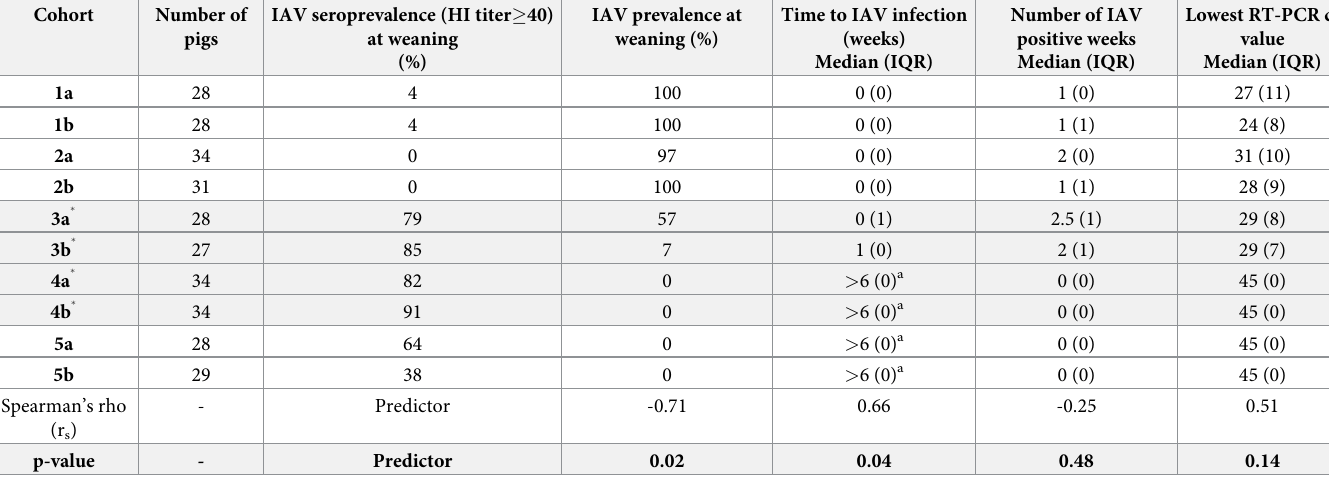
HI, Hemagglutination inhibition assay; IQR, Interquartile range; RT-PCR, Real-time reverse transcriptase polymerase chain reaction; ct, RT-PCR cycle threshold. � Cohorts 3a, 3b, 4a and 4b originated from vaccinated sows. a Time to IAV infection in cohorts 4 and 5 was assigned 6 weeks due to the termination of the study. We did not measure how many weeks those pigs remained IAV negative in the finishing sites.